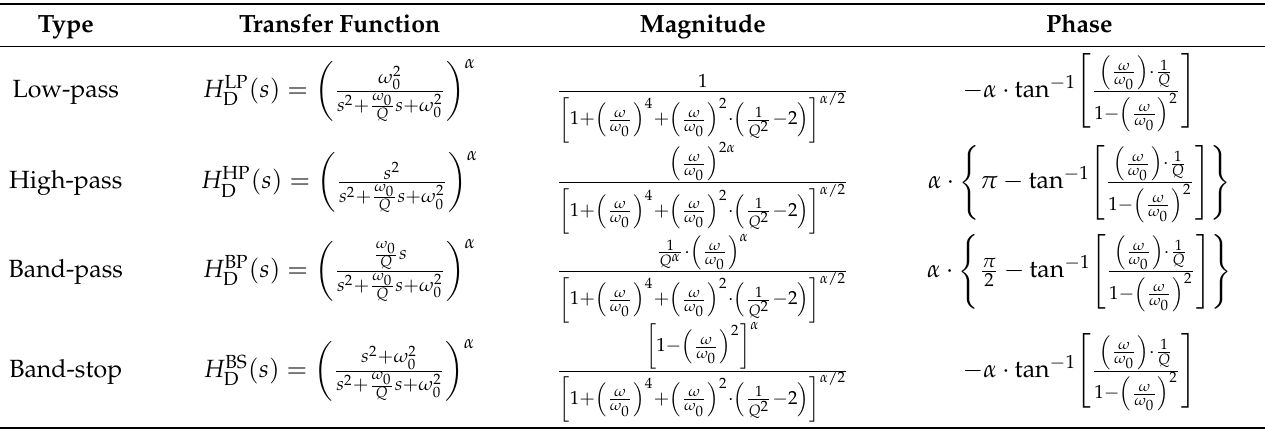
Table 1. Transfer functions and frequency response expressions of the theoretical PLFs ( ω 0 : pole frequency, and Q : quality